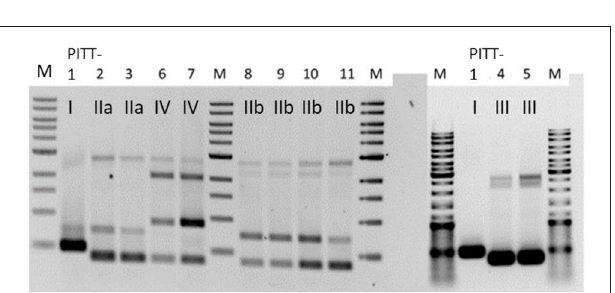
FIGURE 2 | RAPD-patterns of S. hyicus phages PITT-1-11. Pattern I and II a/II b were exclusively found in samples from house 1. Pattern III was identified for 2 phages from both houses. The two phages with pattern IV were both detected in samples from house 2. PITT-1 is shown twice.